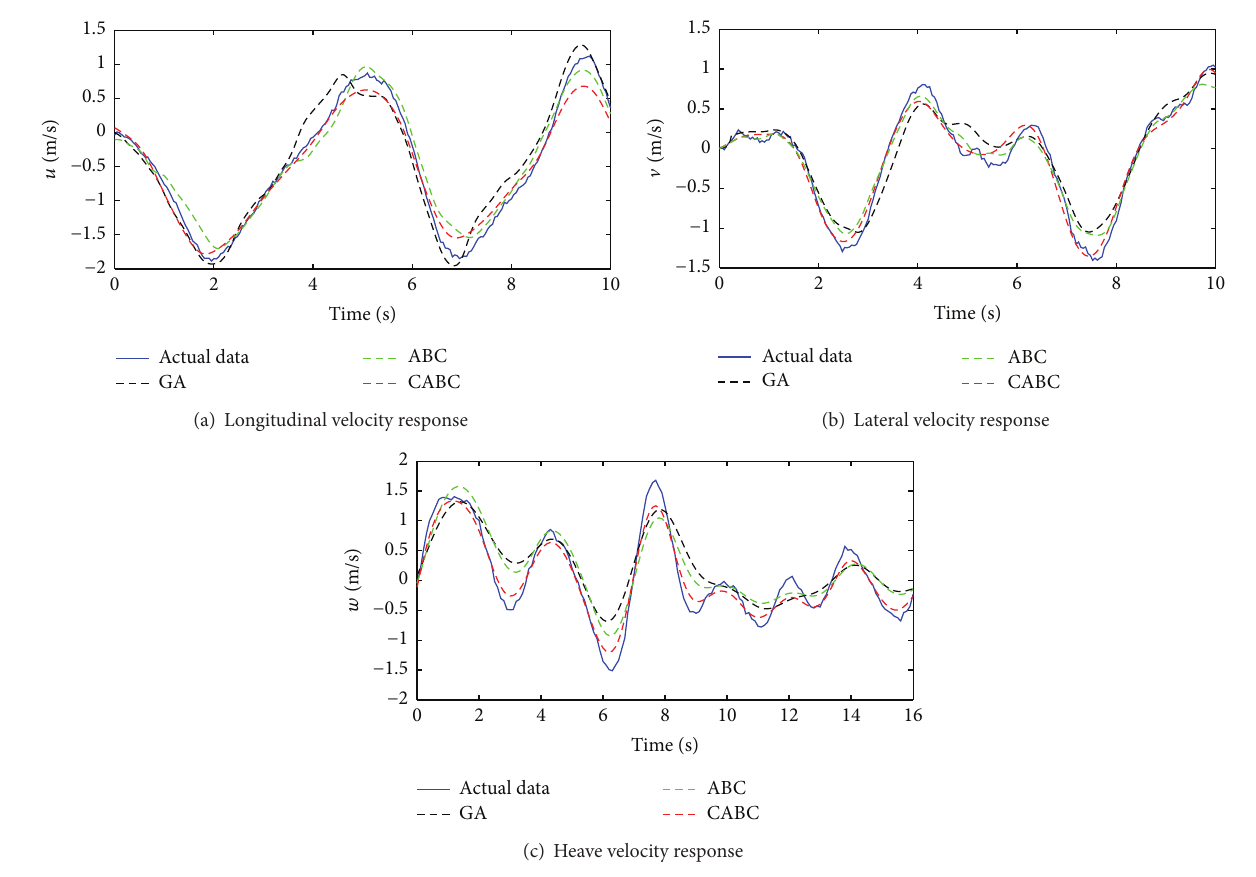
Figure 8: Comparison of the actual and estimated velocities responses.